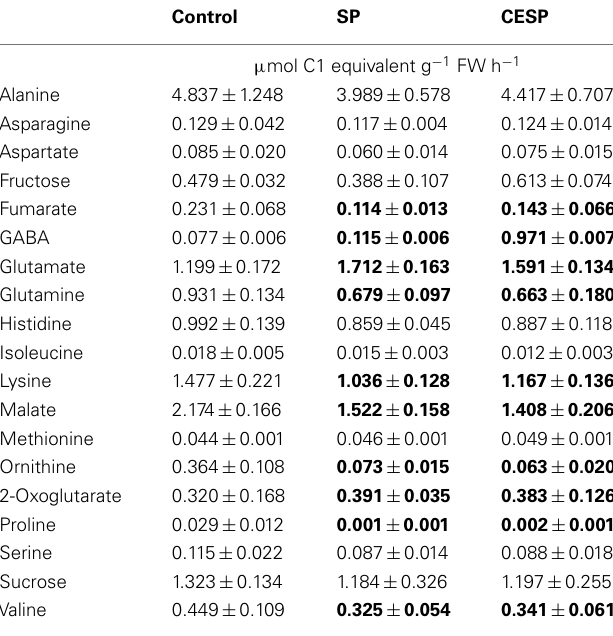
Table 2 | Redistribution of heavy label following glucose feeding of control and treated Arabidopsis